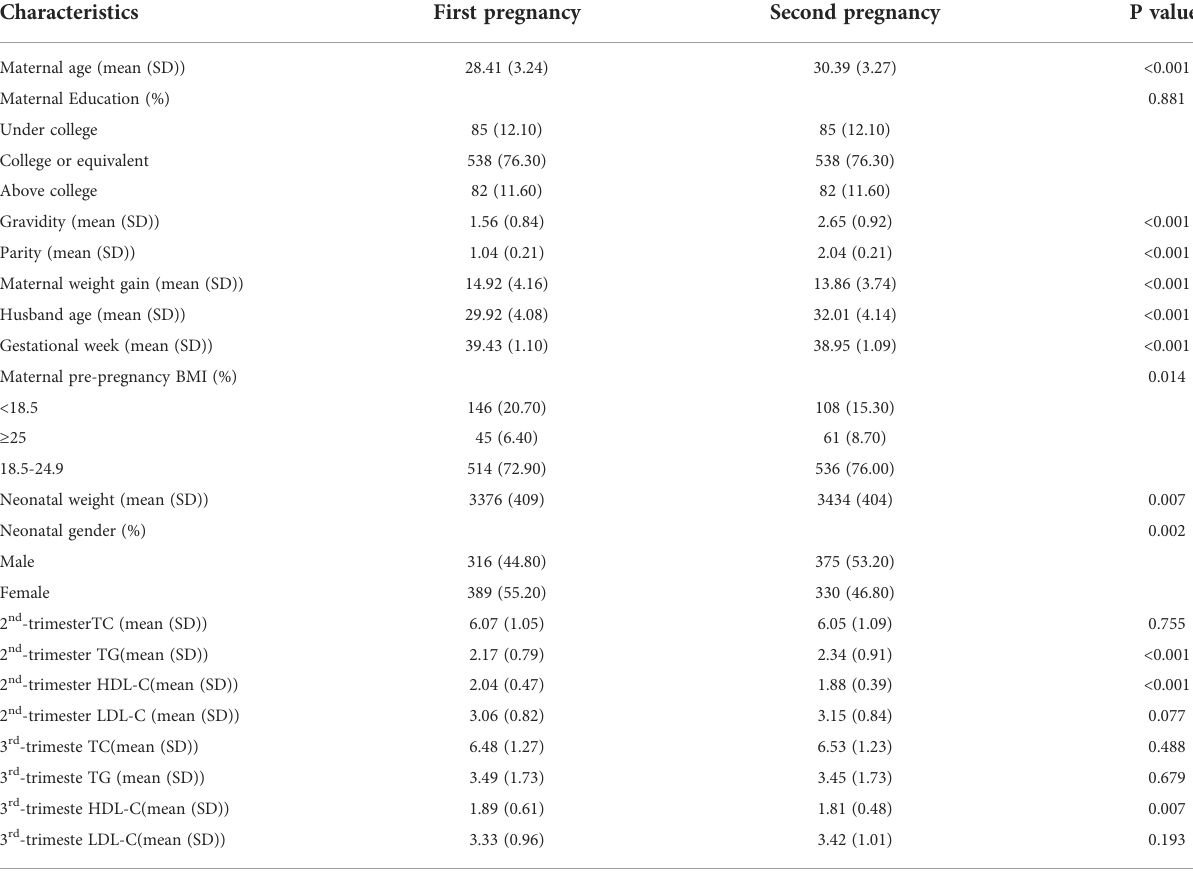
TABLE 1 Overall characteristics of mothers and neonates in the fi rst and second pregnancy.